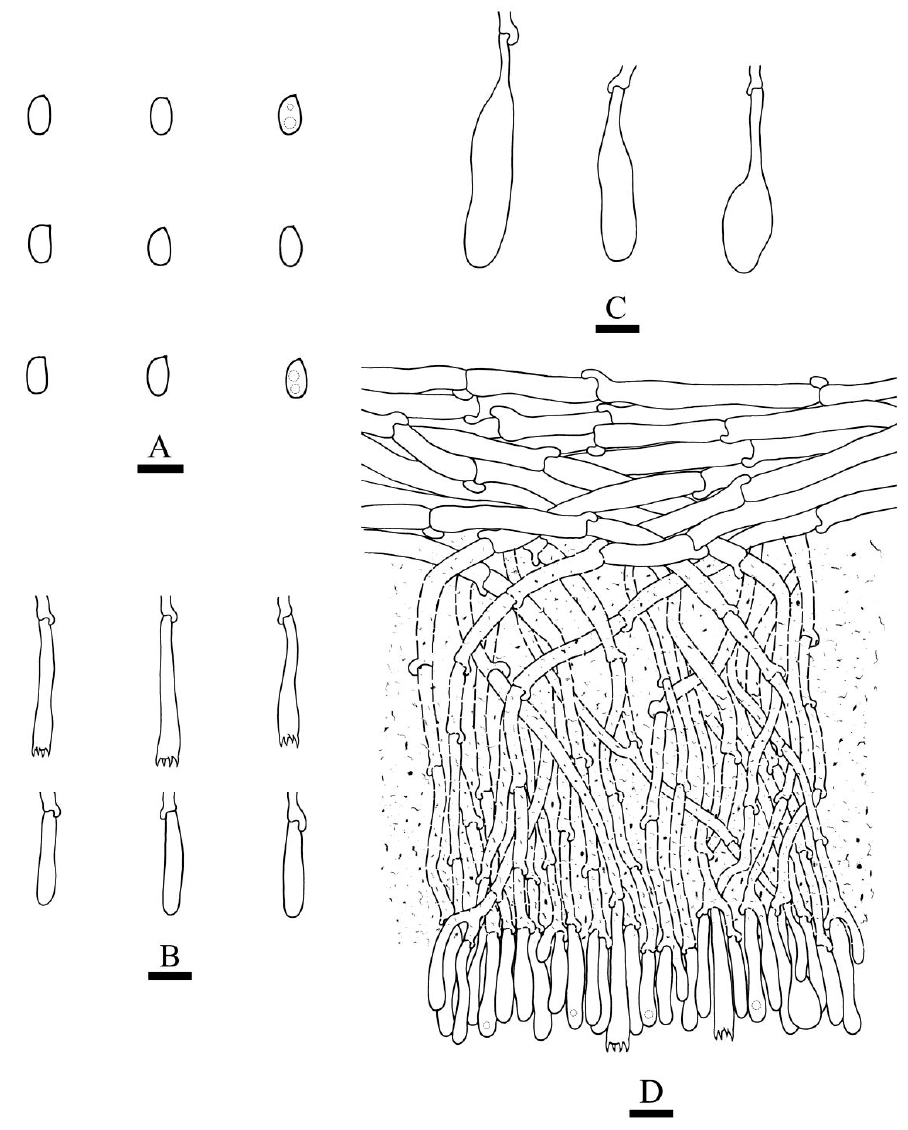
Figure 16. Microscopic structures of Phlebia poroides (drawn from CLZhao 16121, holotype). ( A ) Basidiospores. ( B ) Basidia and basidioles. ( C ) Cystidia. ( D ) A section of hymenium. Bars: ( A ) = 5 µ m, ( B – D ) = 10 µ m.